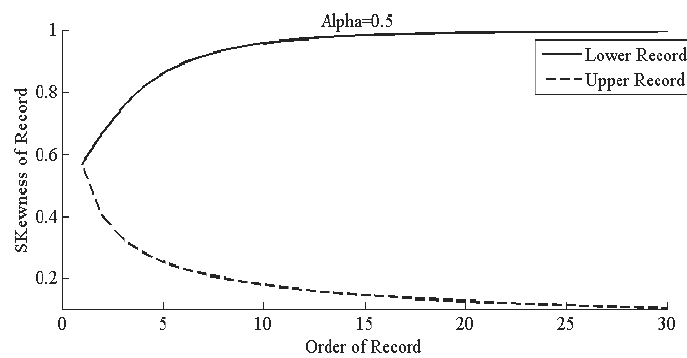
Figure 11 – Skewness coefficient of records.